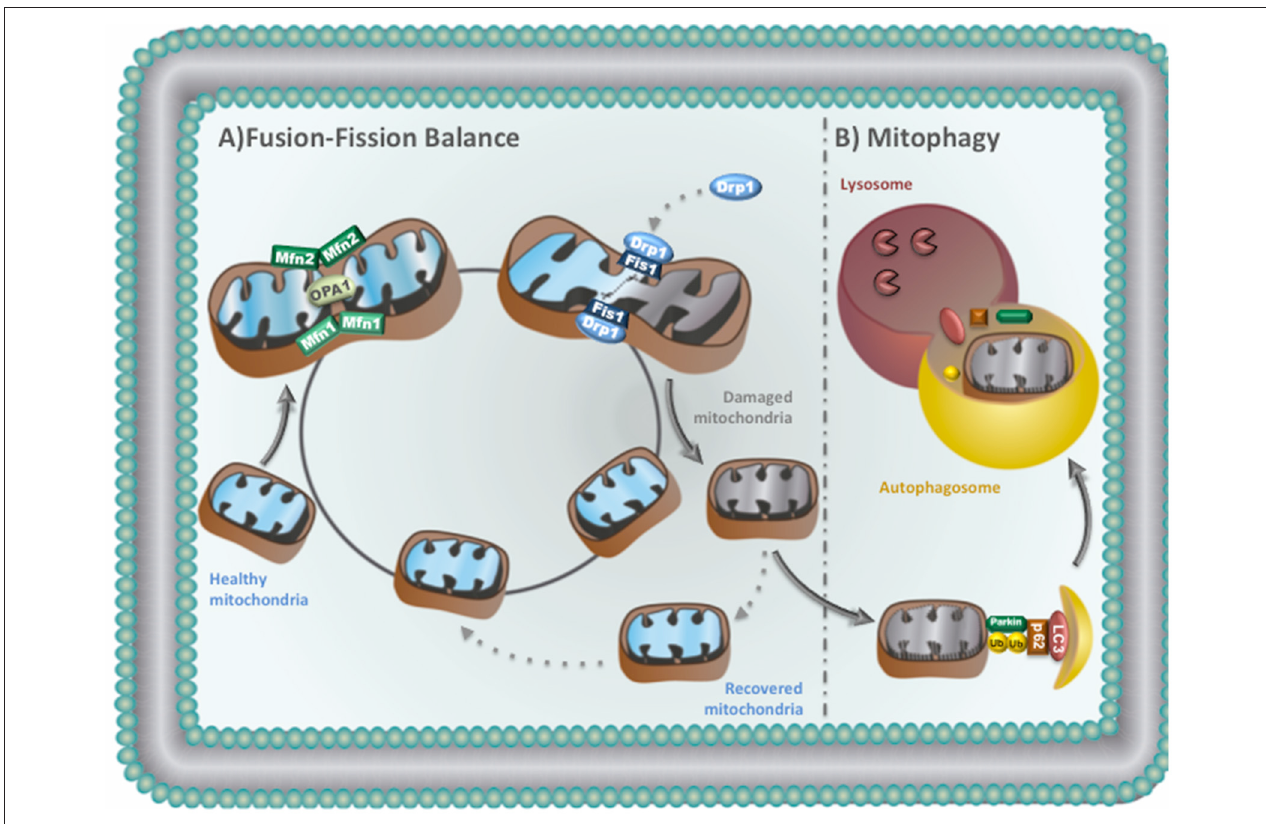
FIGURE 2 | (A) Mitochondrial fusion-fission balance: Mitochondrial fission: Drp1 translocates to mitochondria and binds to Fis1 to promote fission. Daughter mitochondria can be recovered or removed. Recovered mitochondria re-enter in the life cycle to fuse with healthy mitochondria. Mitochondrial fusion: outer membrane fusion is regulated by Mfn1 and Mfn2, while OPA1 is responsible for inner mitochondrial membrane fusion. (B) Mitophagy: damaged mitochondria can be sequestered by autophagosomes. The autophagosomes then fuse with lysosomes to degrade sequestered